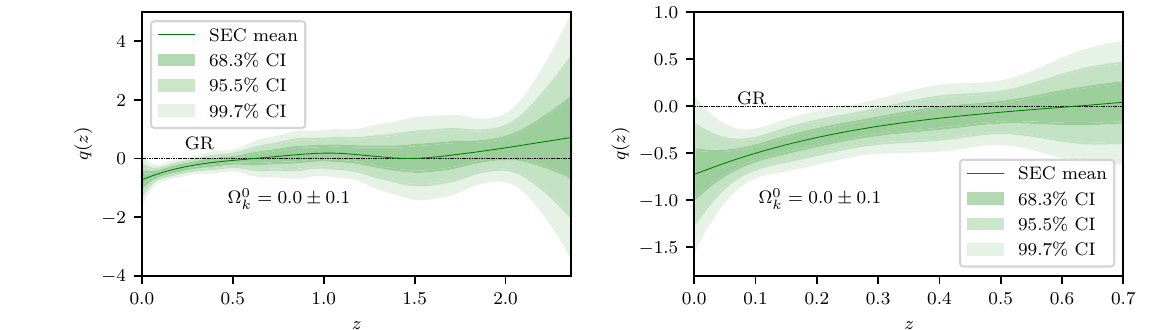
not assume to the respective condition be fulfilled. The dashed lines correspond to the GR fulfillment thresholds